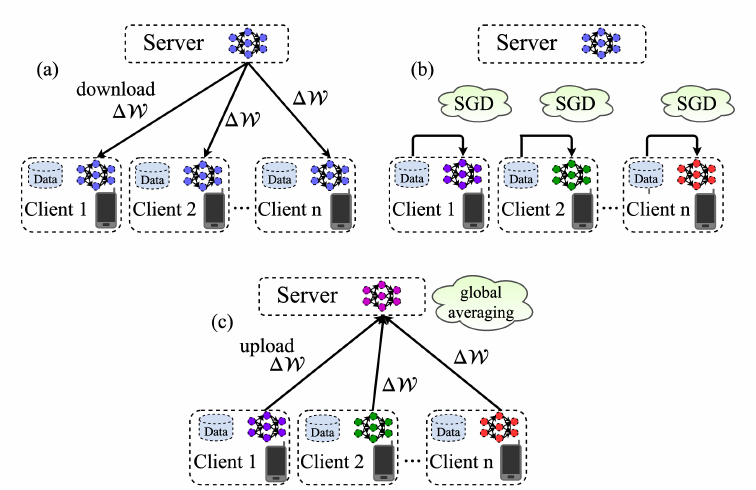
Figure 6. Ref. [55] illustrates a complete round of distributed stochastic gradient descent (SGD) model. In ( a ), clients on the federated network synchronize with the server and download the global ML model. In ( b ), the global model is trained by each client on their local data, adjusting the weighted average of the ML model as per. In ( c ), the new average achieved by each client is updated onto the server, where each update is used to obtain a new weighted average for the global